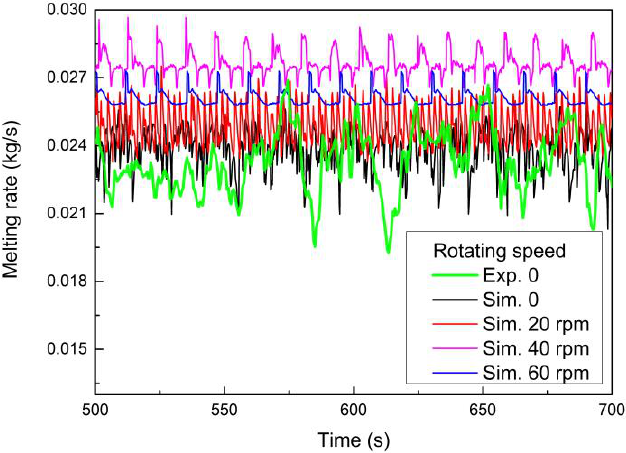
Figure 3. Comparison of electrode melting rates between the experimental and calculated results. The averaged melting rates are 0.0238, 0.0247, 0.0276, and 0.0261 kg/s in the cases rotating at 0, 20, 40, and 60 rpm, respectively. Compared to the static one, the productivities are enhanced by 3.78%, 15.97%, and 9.66% at the rotating speeds of 20, 40, and 60 rpm, respectively. Obviously, the productivity reaches a maximum when the rotating speed